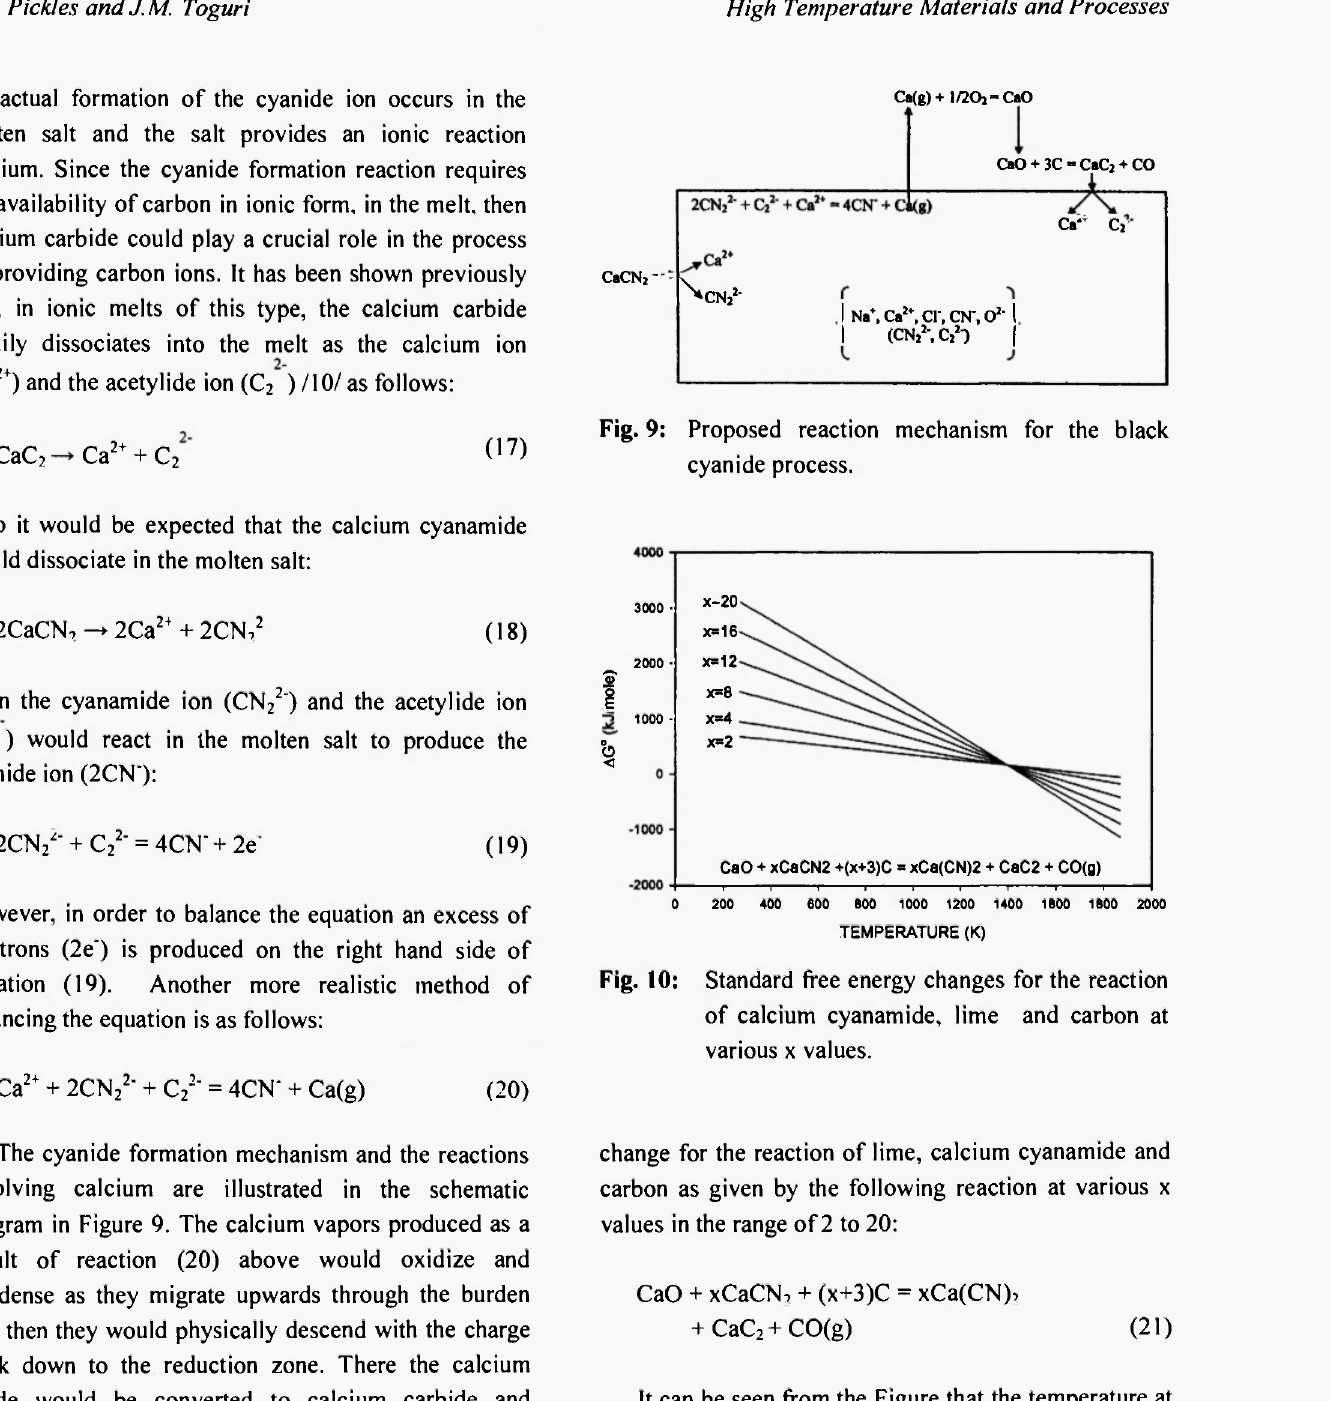
Fig. 9: Proposed reaction mechanism for the black cyanide process.